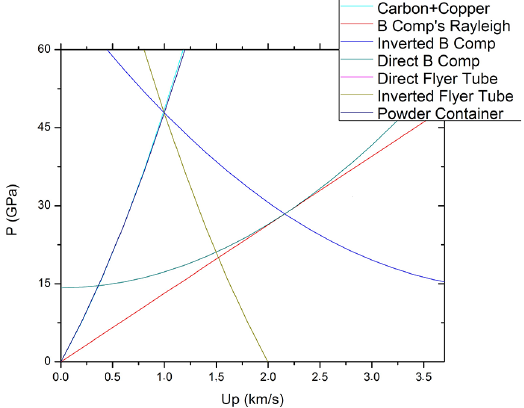
Figure 4. Hugoniot curves obtained by the detonation of Composition B explosive. The intersection point of the direct Hugoniot of the flyer tube with the Composition B inverted Hugoniot gives P FT 47.85 GPa and (U ) 999.52 m/s. The impact velocity of P FT ≅ the flyer tube is about 1,999.04 m/s, providing an M/C ratio ≅ about 0.718. Besides that, one can observe that the pressure generated on the mixture of copper and carbon black was about 48.16 GPa, with particle velocity close to 994.46 m/s. In order to estimate the temperature reached by the detonation, the method described by Meyers 28 to the temperature rise associated with shock waves was adopted. The standard solution is of the form shown in Eq. 10.